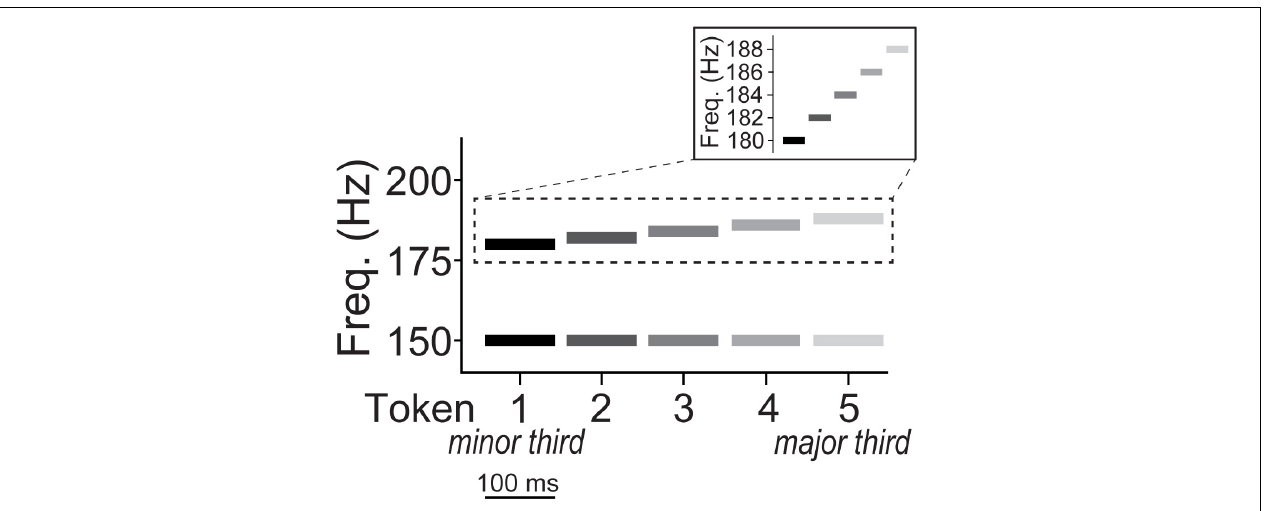
FIGURE 1 | Depiction of musical interval continuum. The bass note of all five interval tokens was fixed at an F0 of 150 Hz while the upper note’s F0 ranged from 180 to 188 Hz corresponding to just intonation frequency ratios of 6:5 (minor third) and 5:4 (major third), respectively. The two notes of a given token were played simultaneously as a harmonic interval on a given trial. The individual notes of each dyad were constructed of complex tones consisting of 10 equal amplitude harmonics added in cosine phase (harmonics not